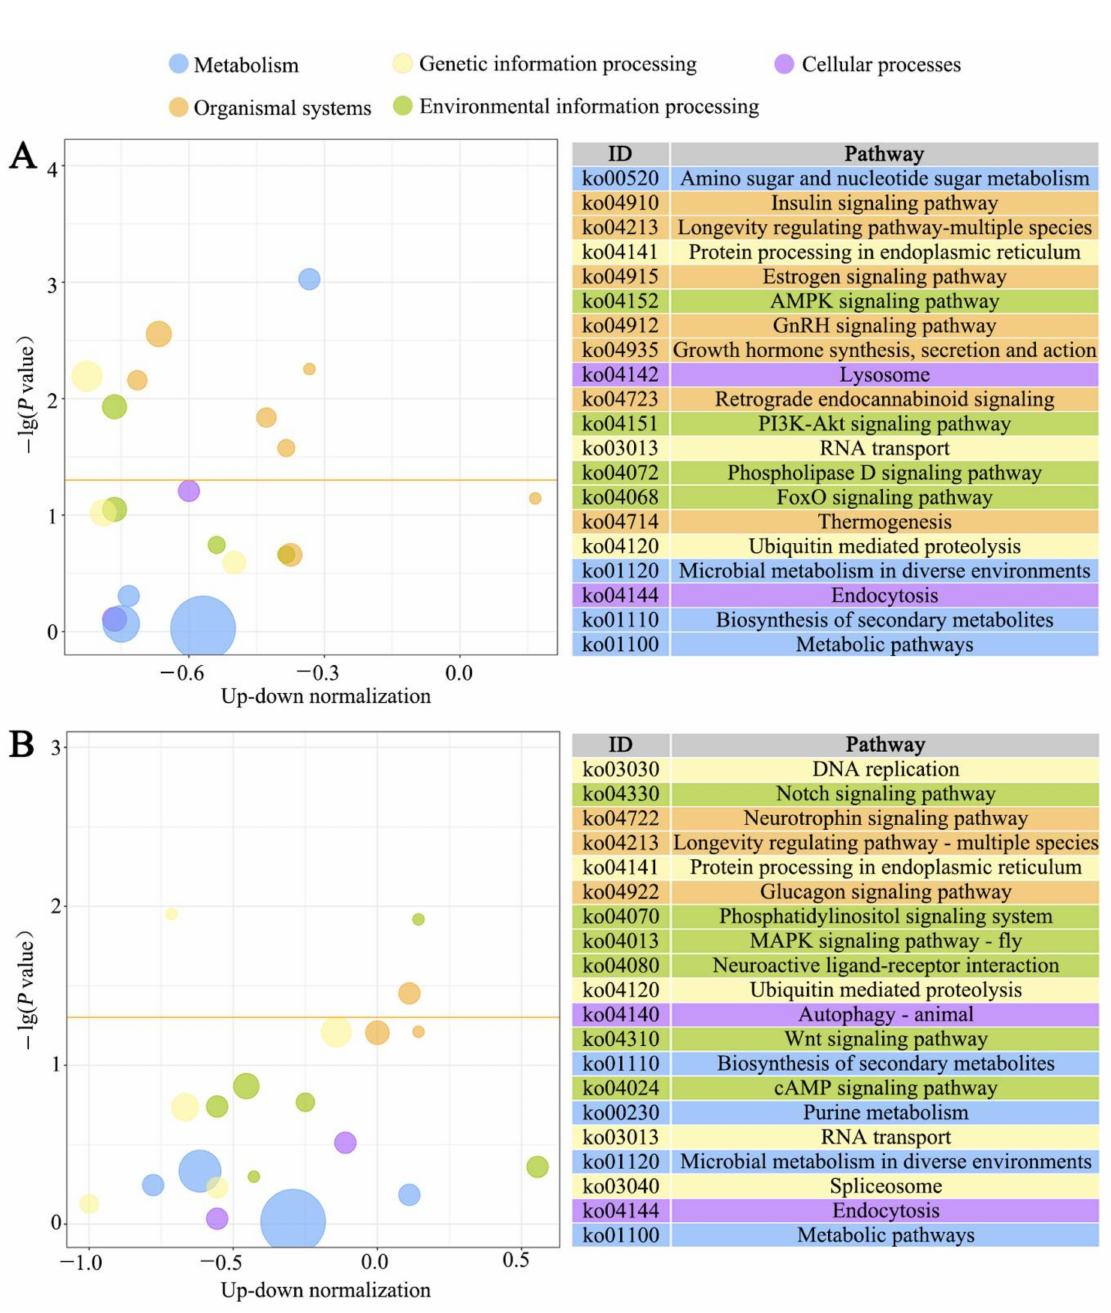
Figure 5. KEGG pathways enriched by DEGs in A. c. cerana workers’ midguts at 7 dpi ( A ) and 10 dpi ( B ) with N. ceranae